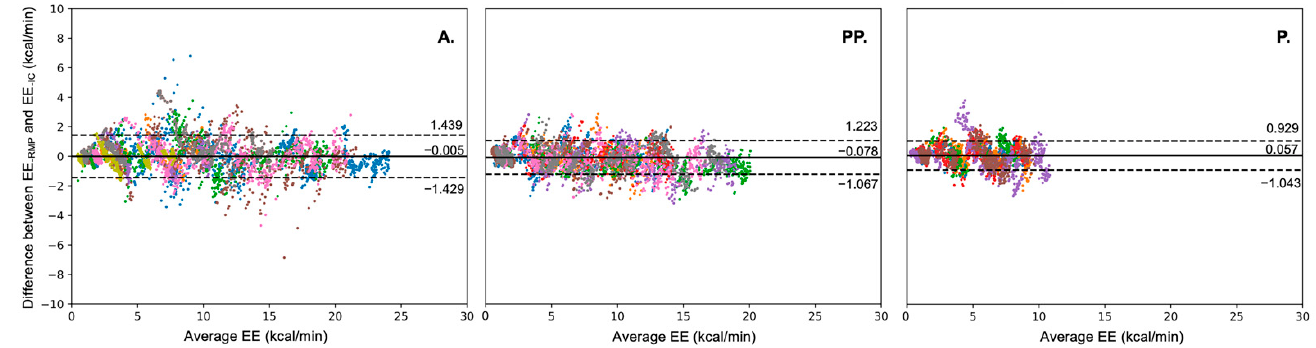
Figure 8. Difference between EE -RMP and EE -IC in the three groups. A: adult; PP: post-pubertal; P: pubertal; EE -IC : energy expenditure measured from indirect calorimetry; EE -RMP : energy expenditure estimated from respiratory magnetometer plethysmography; The mean difference (bias) between EE -RMP and EE -IC is depicted by the solid line, and the 95% confidence intervals (± 2SD) are depicted by the dashed lines. Average EE = (EE -RMP + EE -IC )/2. Each color represents an individual. Each color represents data from a unique participant.